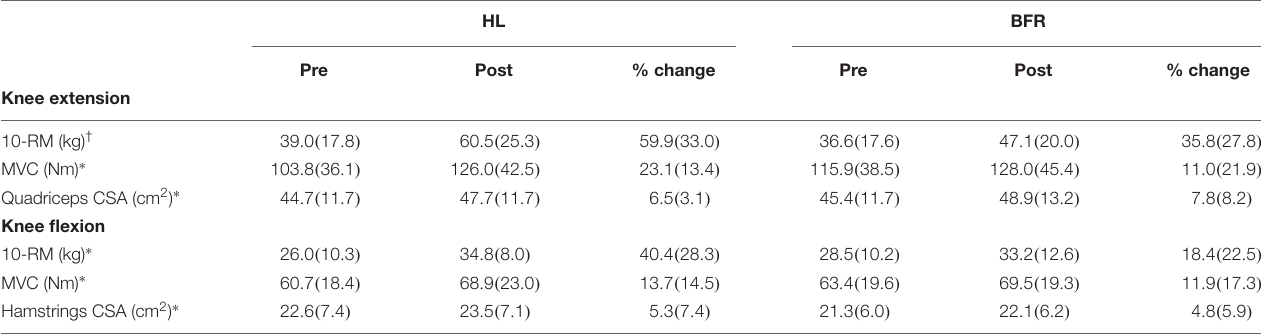
TABLE 2 | Muscle strength and mass measurements before and after high-load (HL) and blood flow restricted (BFR) training presented as mean (standard deviation).